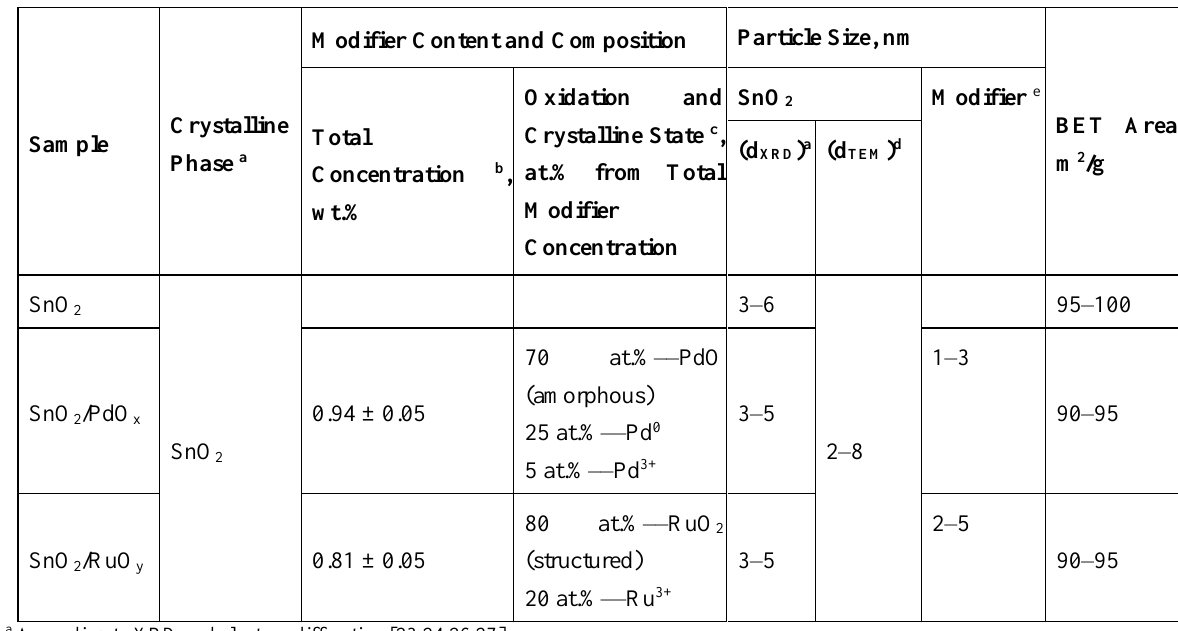
Table 1. Materials composition and microstructure parameters.